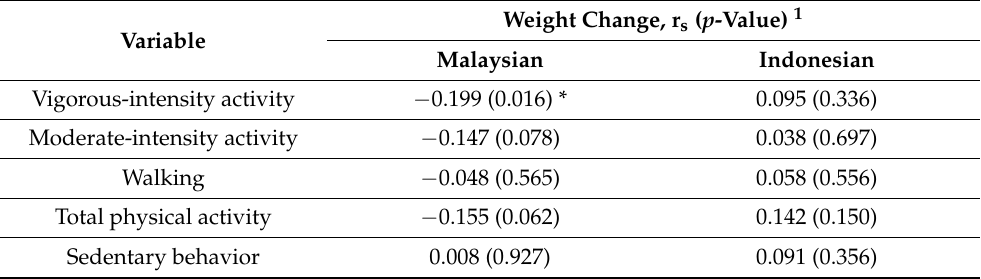
Table 3. Correlations between the studied variables after adjustment for gender and